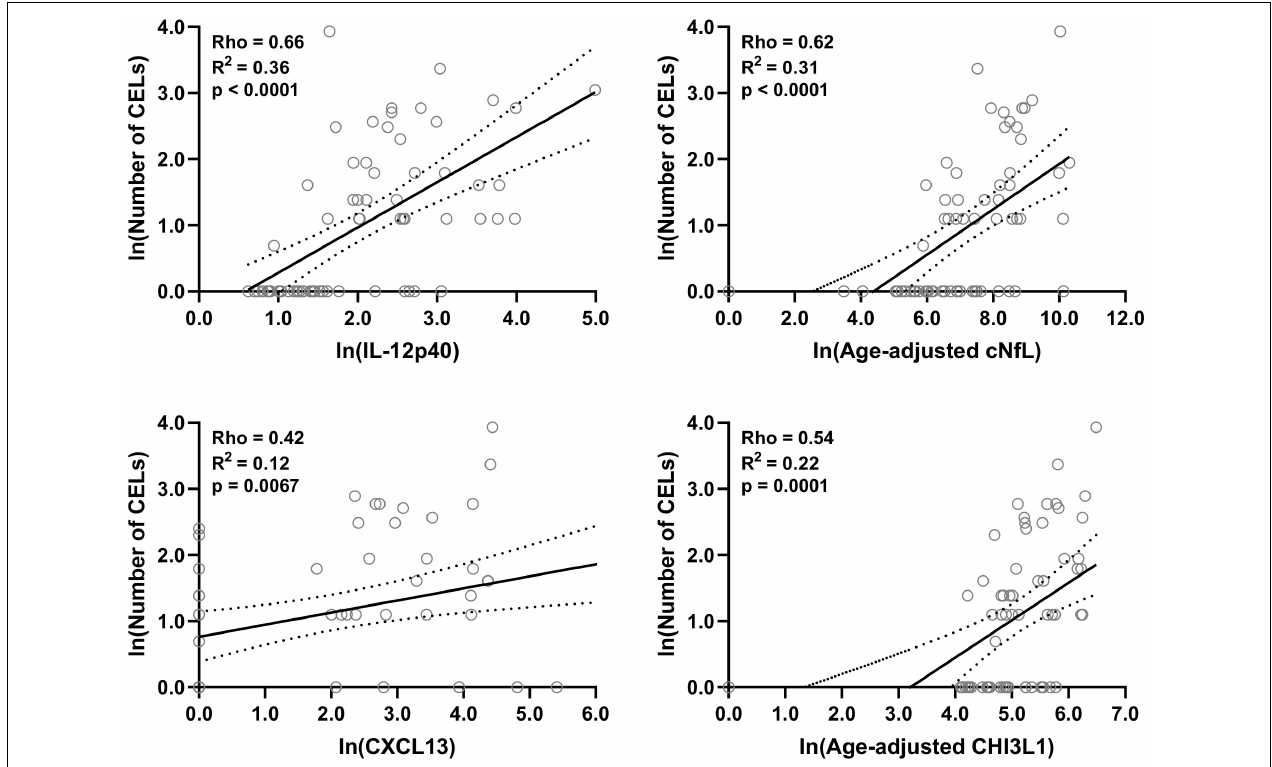
FIGURE 4 | In the training cohort, within MS patients ( n = 70) correlations between number of CELs and all biomarkers were analyzed; Only for statistically significantly ( p < 0.01; Spearman correlation analysis) correlated biomarkers linear regression with number of CELs as a dependent variable was analyzed. Solid line represents “line of best fit,” and dotted line represents 95% confidence